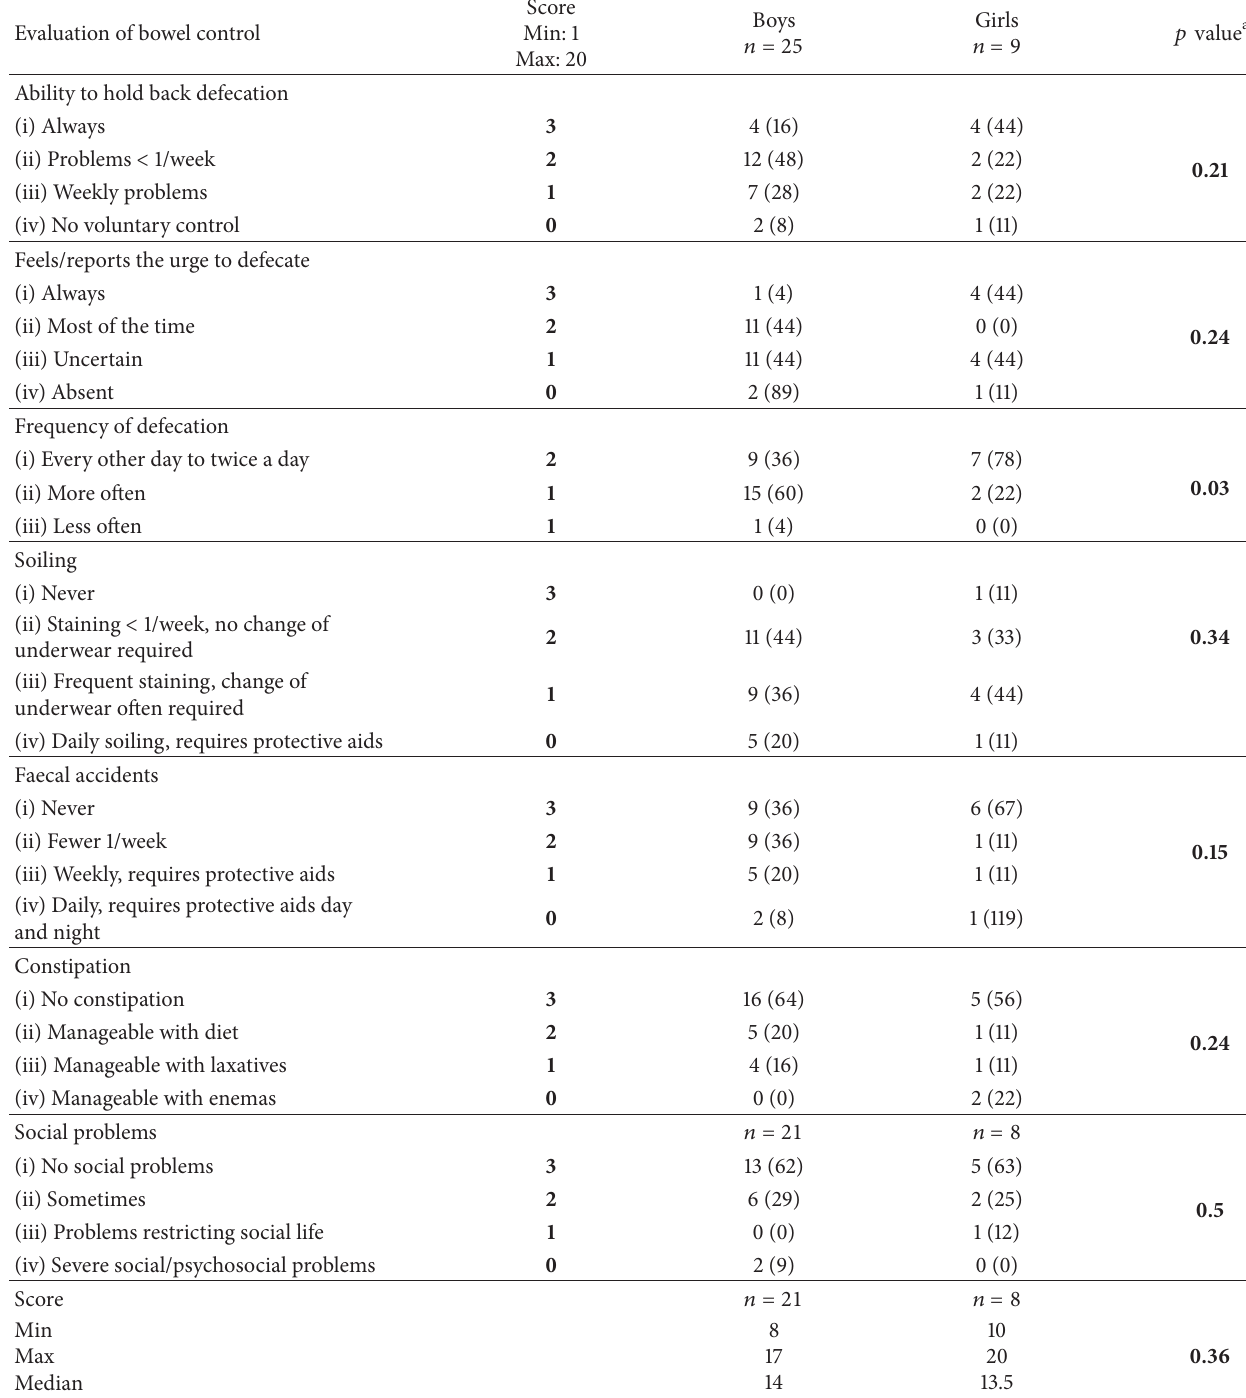
Table 6: Bowel Function Score (BFS). Patients 4 years of age and older. Ranging bowel function from worse to better with a score from 1 to 20 (1: very poor and 20: very good)